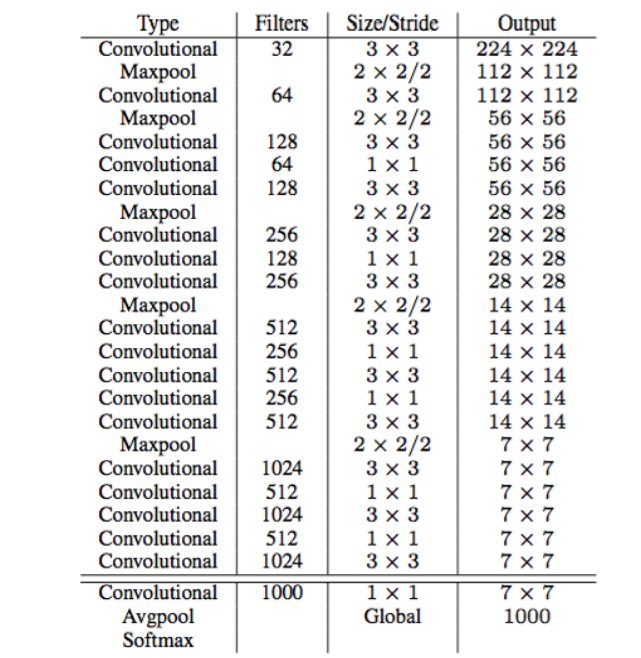
Figure 6. Darknet19 architecture.